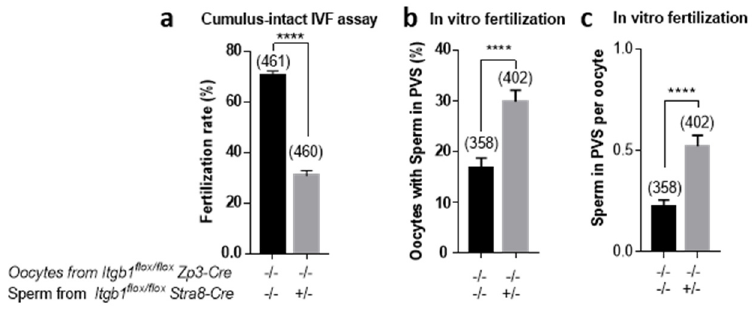
Figure 5. In vivo analysis of the fertilizing ability of sperm from Stra8-Cre +/ − Itgb1 flox/flox males when inseminated with oocytes from Zp3-Cre − / − Itgb1 flox/flox females. ( a ) A significant difference in the fertilization rate (FR) (mean ± s.e.m.) was obtained following in vitro fertilization (IVF) in cumulus-intact assay between the control group (70%) and group using Itgb1 gene-deleted sperm (30%) ( p < 0.0001). ( b ) While 16% of the oocytes presented sperm in their PVS in the control group, 29% contained PVS sperm in the group of oocytes inseminated with sperm from Stra8-Cre +/ − Itgb1 flox/flox males ( p < 0.0001). ( c ) The mean number of sperm per oocyte was 0.22 ± 0.03 in the control group versus 0.52 ± 0.05 in the group using deleted sperm ( p < 0.0001). The numbers in parentheses represent the number of used oocytes in each group. **** p < 0.0001.